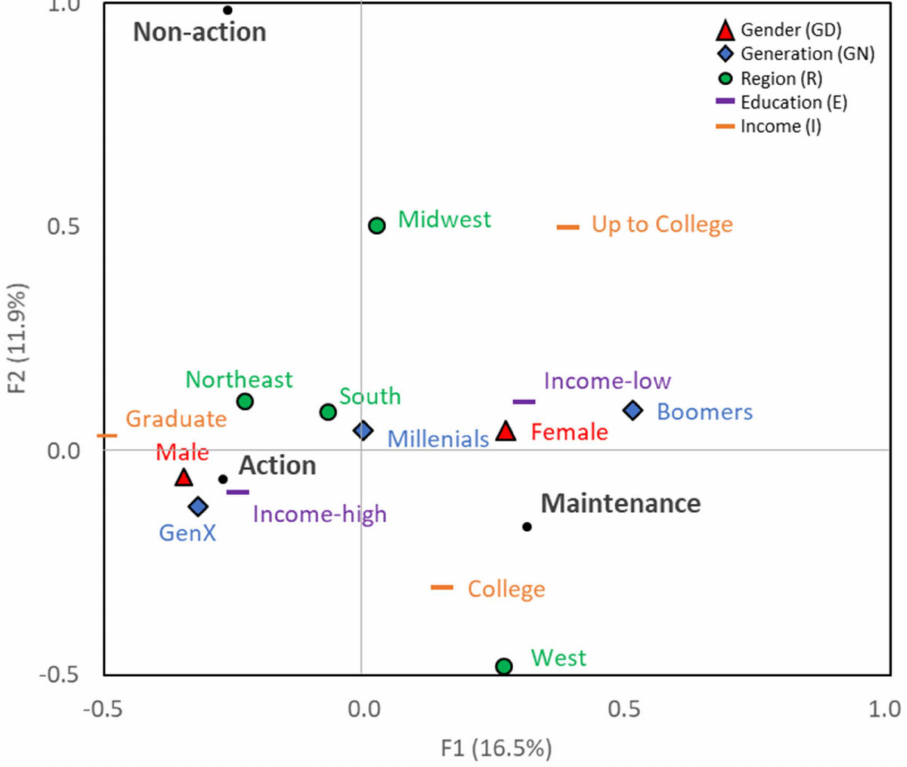
Figure 2. Multiple correspondence analysis biplot of healthy diet stage-of-change with consumer segment